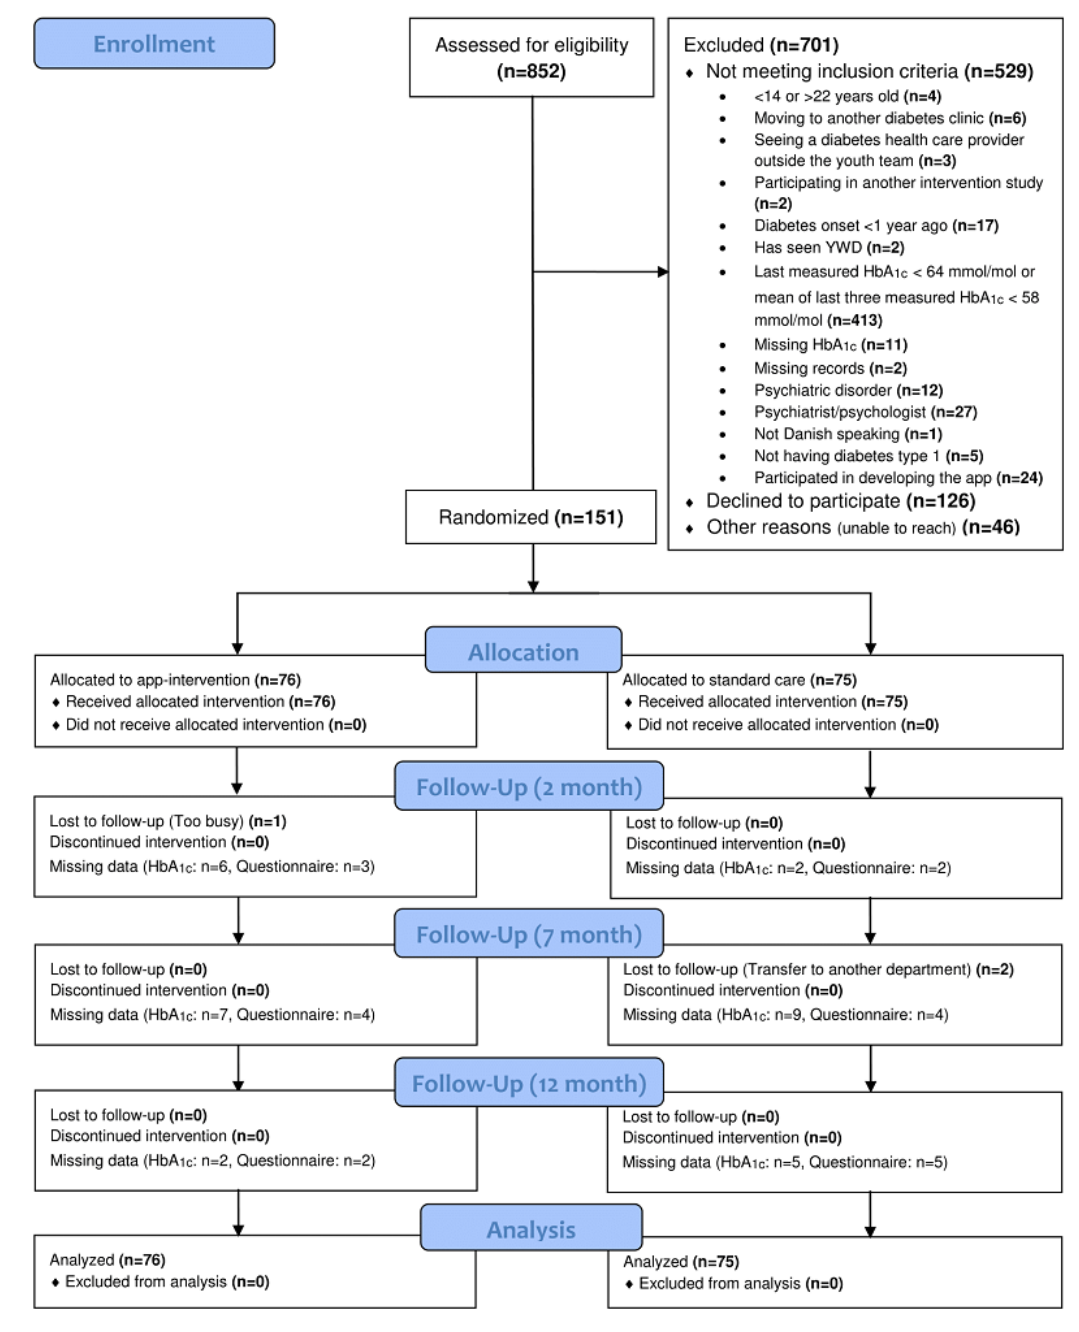
Figure 1. Participant flow